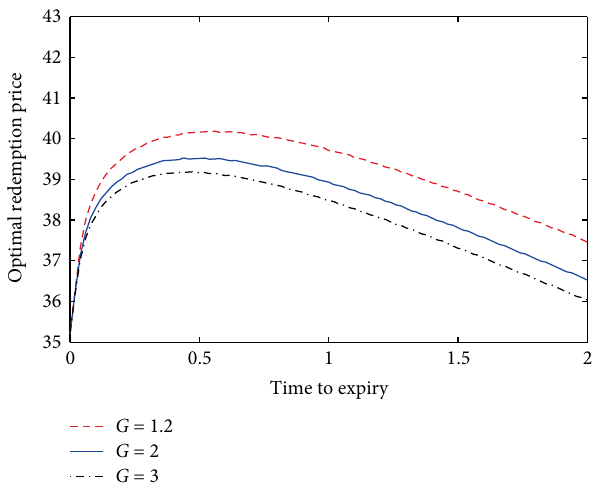
8: Optimal redemption prices with 𝐶 = 0.03, 𝑀 = 1, 𝑌 = 1.5, 𝑇 = 2, 𝐾 = 50